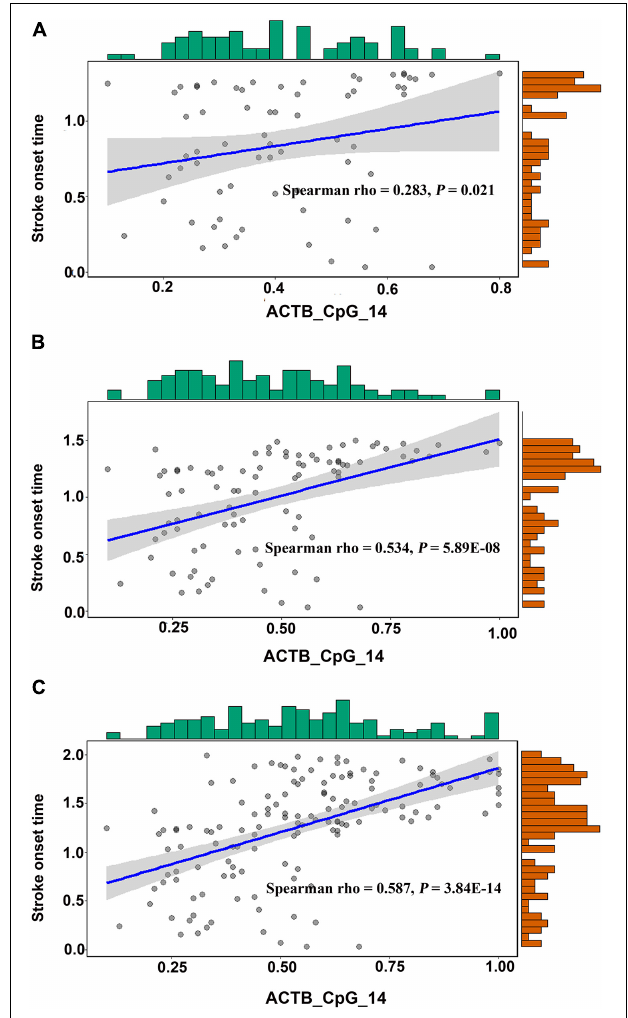
FIGURE 2 | Positive correlation between ACTB_CpG_14 methylation and onset time of stroke for cases with onset time ≤ 1.32 years (A) , ≤ 1.5 years (B) , and < 2 years (C)